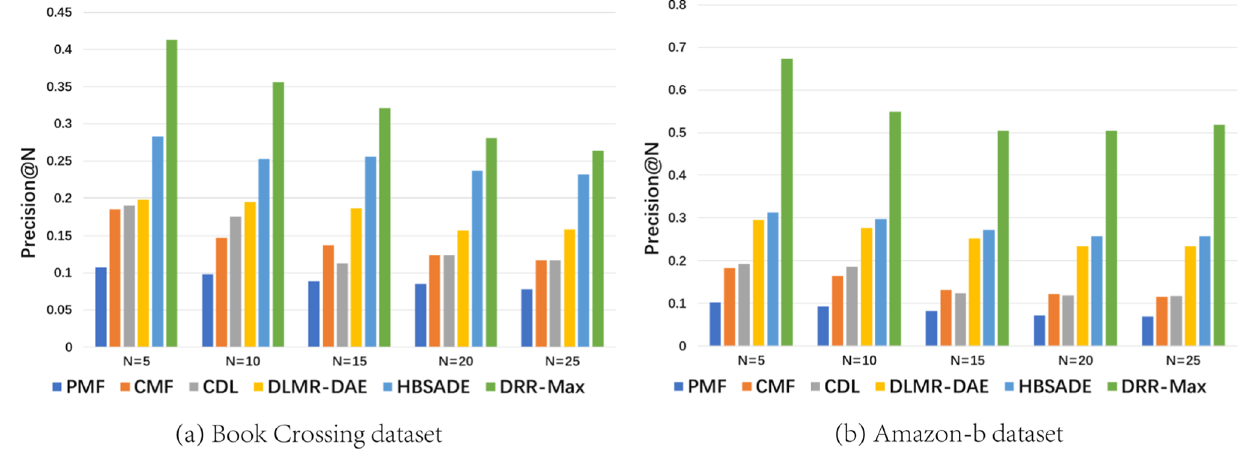
Fig. 4 Procession for Book-crossing and Amazon-b data